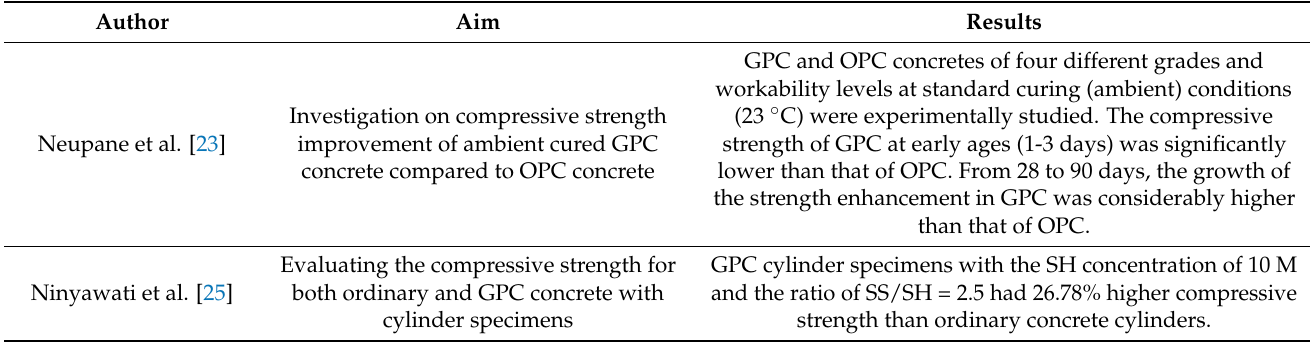
Figure 2. The effectiveness of w/s ratio and w/c ratio on the flow of geopolymer mortars (GPM) and Portland cement mortars (PCM) mixes: ( a ) the constant past value; ( b ) the constant free water content [29]. Table 1. Geopolymer concrete (GPC) compressive strength and influential factors on the improvement of GPC